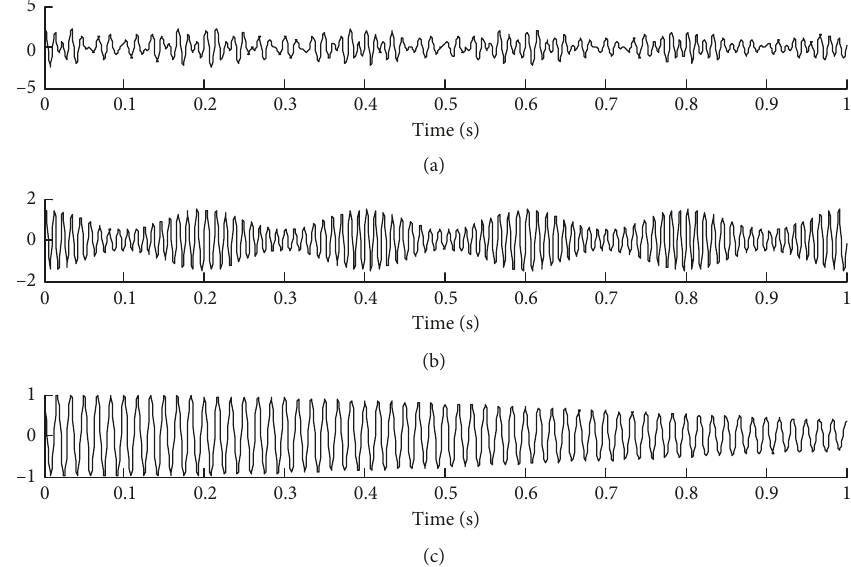
Figure 3: The time-domain waveforms of simulation signal x 1 ( n ) in equation (8) and its components. (a) The mixed signal x 1 ( n ); (b) the AM-FM component; (c) the attenuating